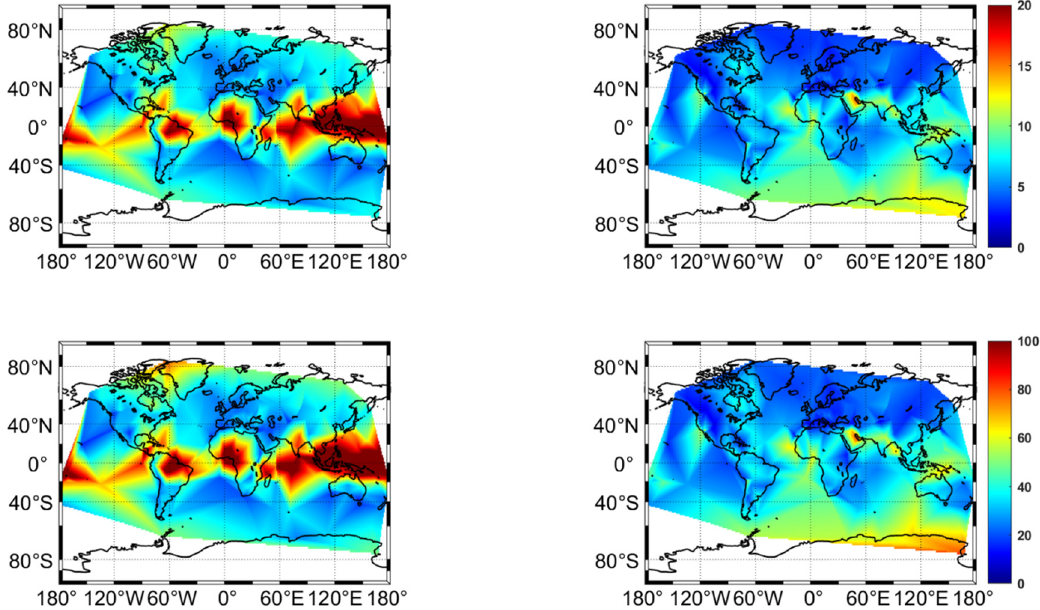
Figure 7. dZTD RMSs (upper panels) and RMSs of the SPP biases on the vertical direction (lower panels) generated by dZTD from saas+GPT (left panels) and UNB3 (right panels) models at globally distributed IGS stations (unit: cm). Equation (6) indicates that the residual ZTD will be projected to the SPP solution with a mapping coefficient vector 𝒎 = 𝑫 (cid:3051)(cid:3548) A T D − 1 α . To further analyze the relationship between dZTD and the SPP biases on the vertical direction, the means of the mapping coefficient between dZTD and the SPP biases on the vertical direction at globally distributed IGS stations are shown in Figure 8. It can be seen that the mapping coefficient is negative and approximately symmetrical along the equator. The mean value reaches the minimum